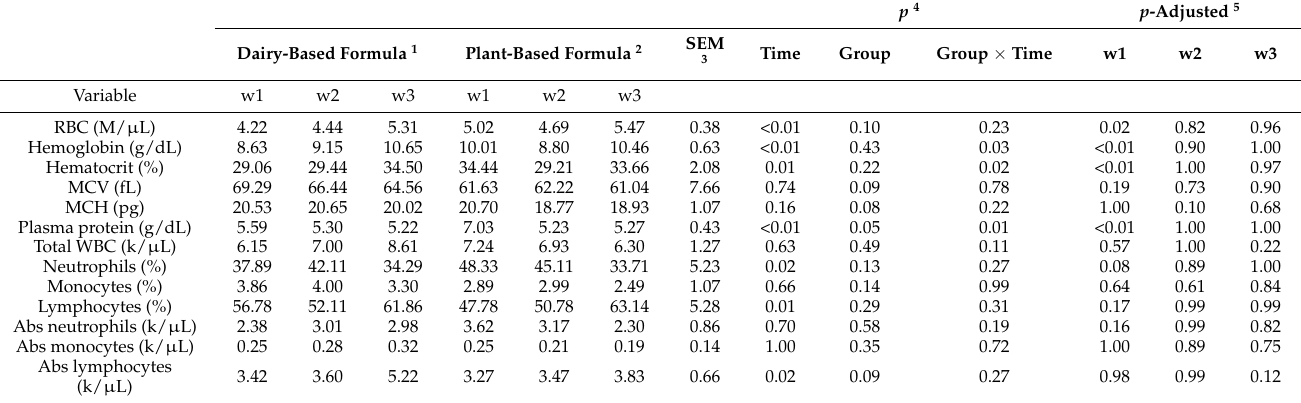
Table 6. Cell plasma count variables (group average) by week of age (w1, w2, w3) of piglets fed either a dairy-based or a plant-based formula ( n = 9/group) from postnatal day (PND) 2 until PND 21. p 4 p -Adjusted